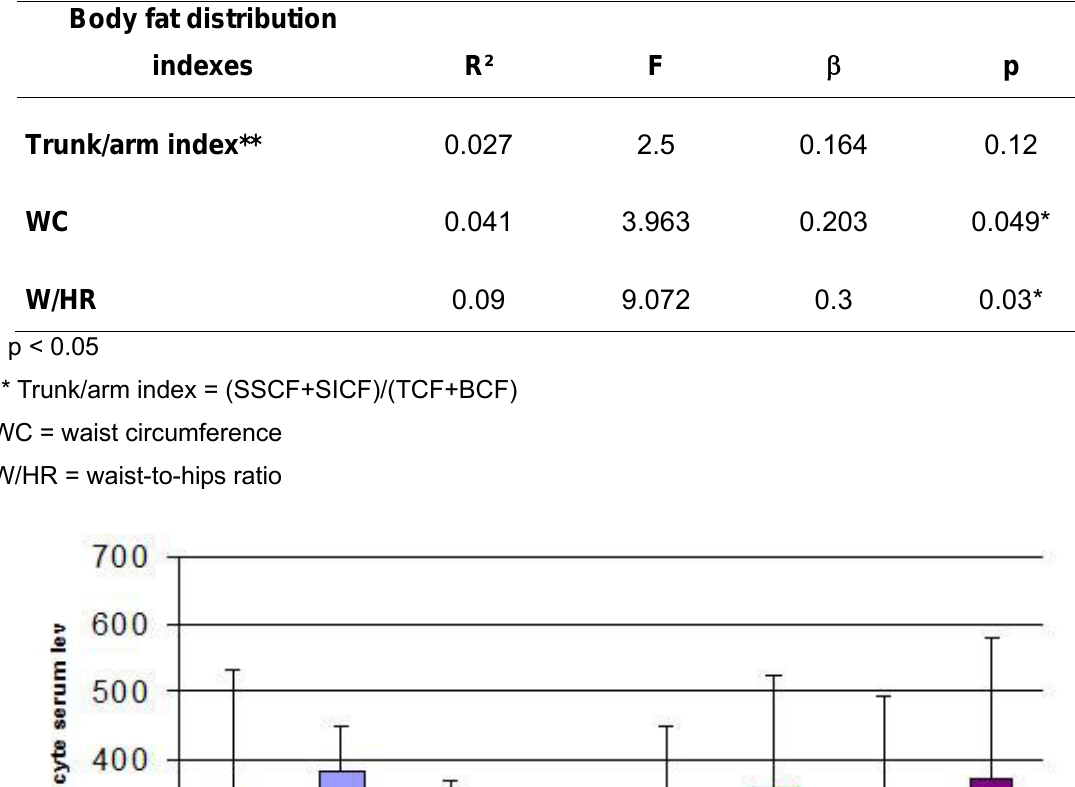
Table 4. Results of the univariate linear regression analyses between treatment duration and body fat indexes of 94 HIV-positive individuals undergoing HAART and assisted at the Nutrition and Tropical Diseases Outpatient Hospital, Botucatu Medical School - São Paulo State University (FMB - UNESP), 2003/04.